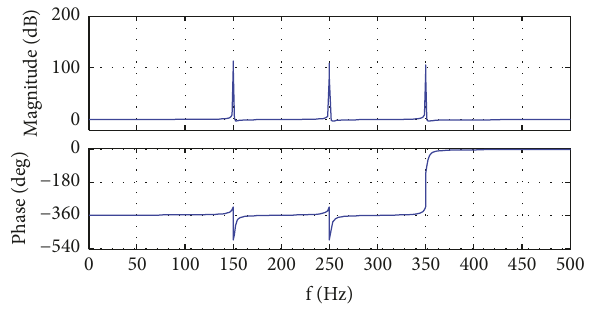
Figure 6: The bode diagram of 𝐺 ℎ (𝑠)